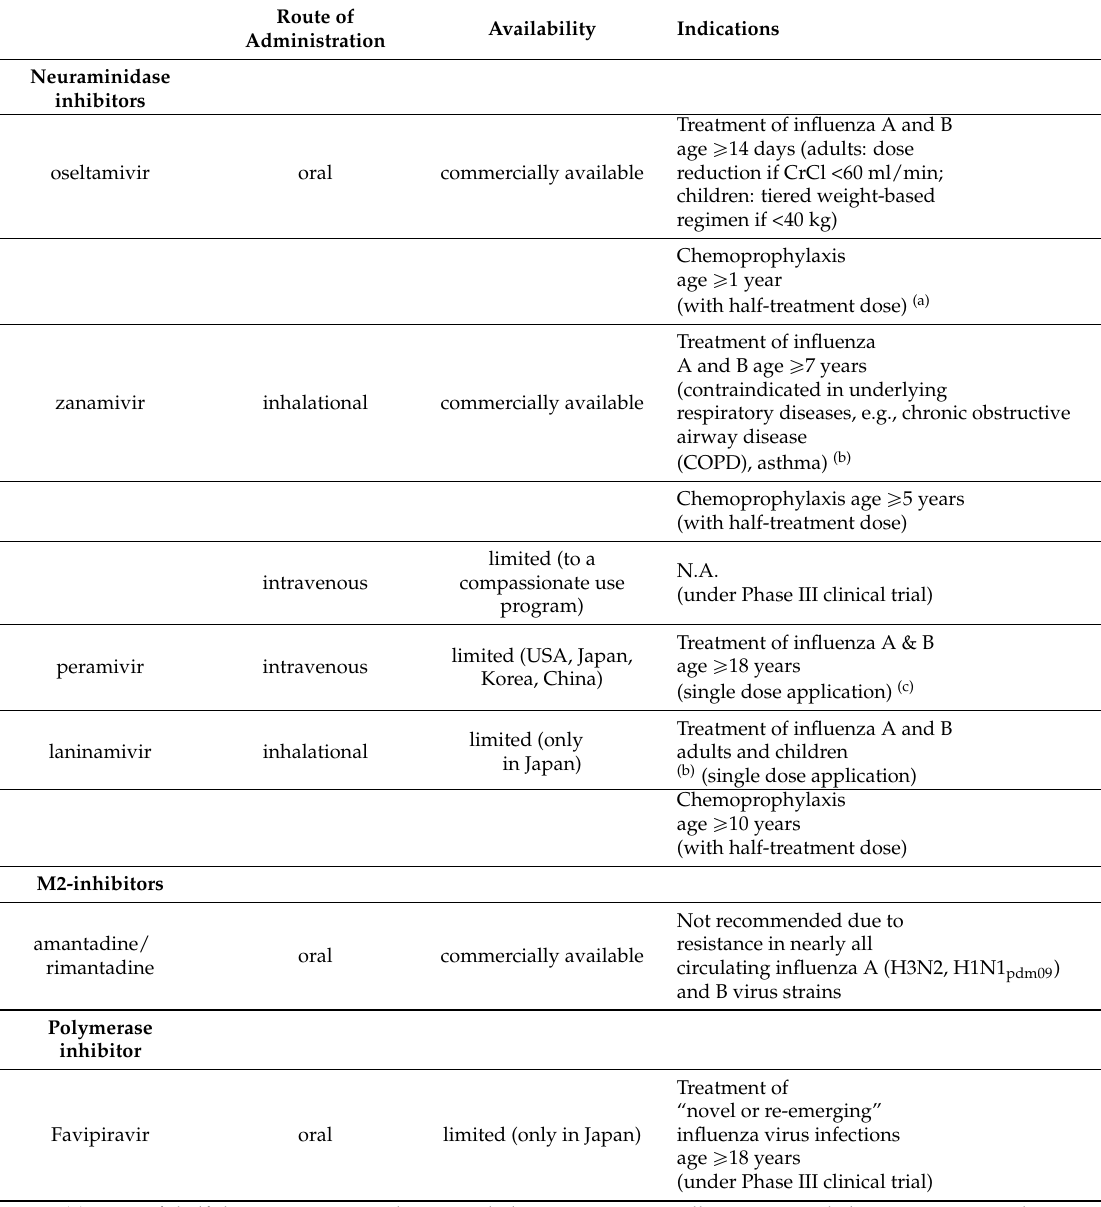
Table 1. Potentially available antiviral agents for treatment and prevention of influenza